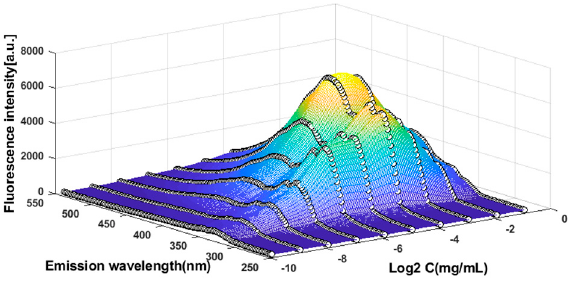
Figure 4. The CEM spectrum of heavy oil with 19 interpolations in the concentrations range of 1.2 ppm to 625 ppm.